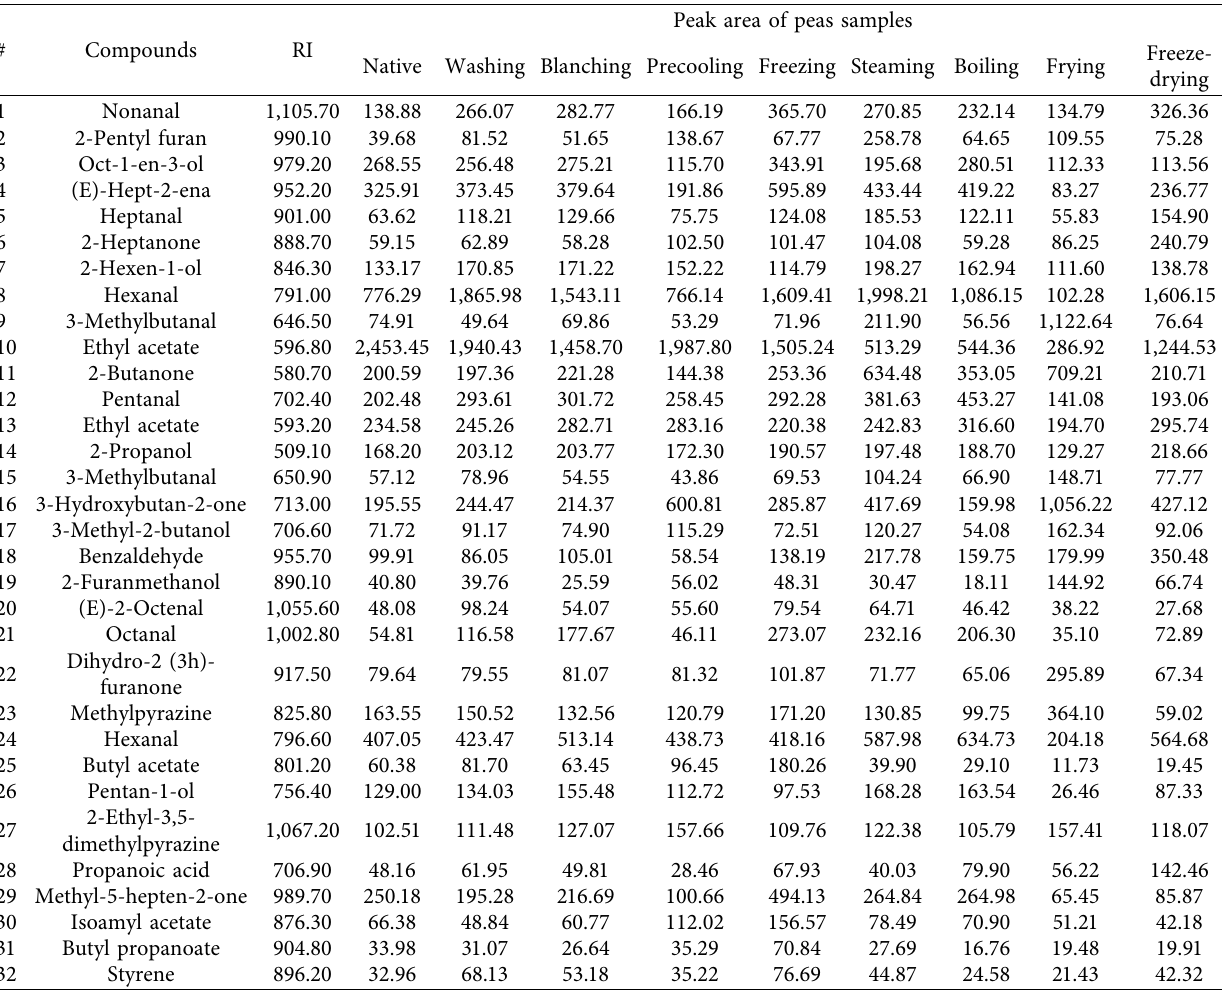
Figure 2: Gallery plot fingerprint of peas samples with different treatment methods. Table 1: Peak area of volatile compounds of peas under 9 different treating methods via